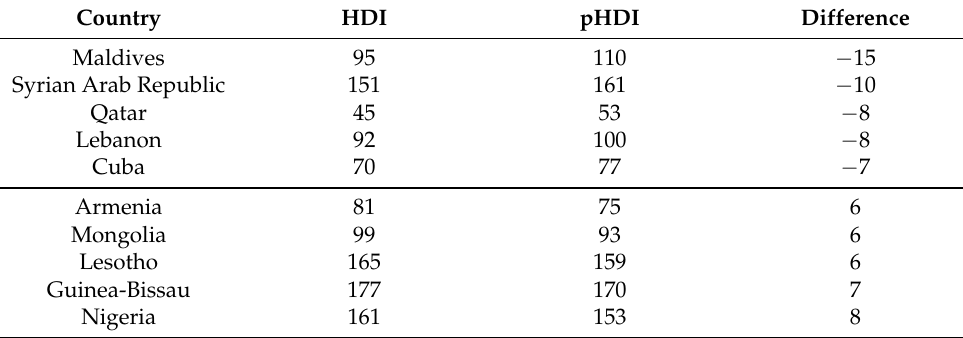
Table 5. Countries with higher ranking position